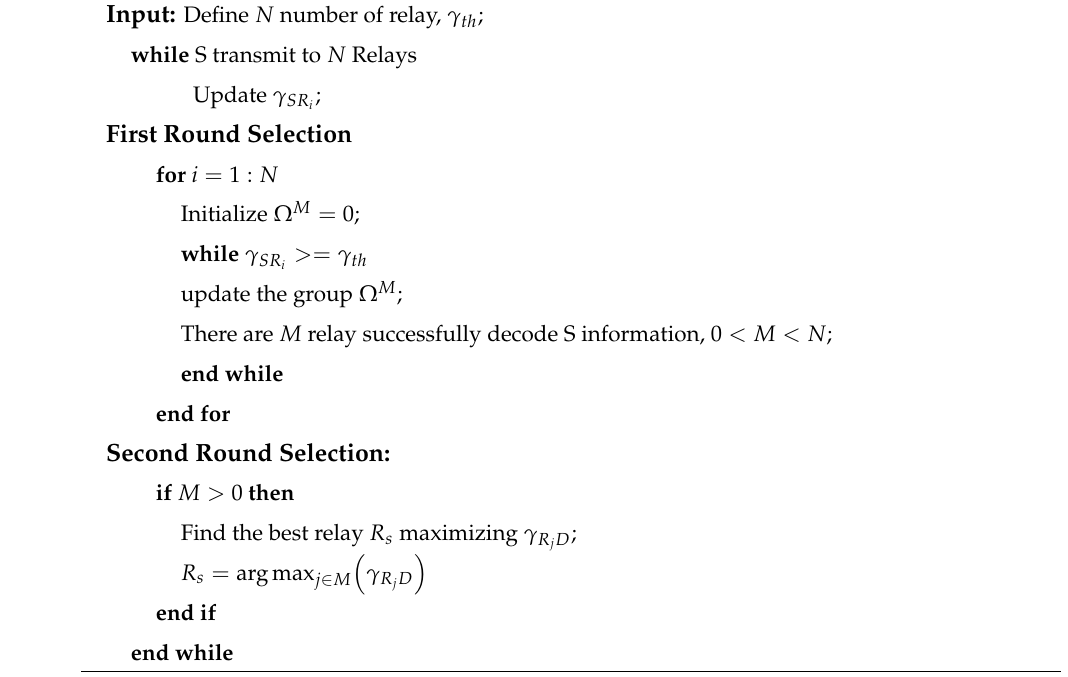
Algorithm 1 Two-Round Relay Selection (2-RRS) Scheme